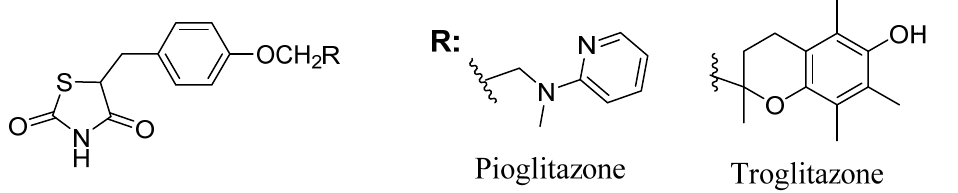
Figure 2. Structure of glitazones.